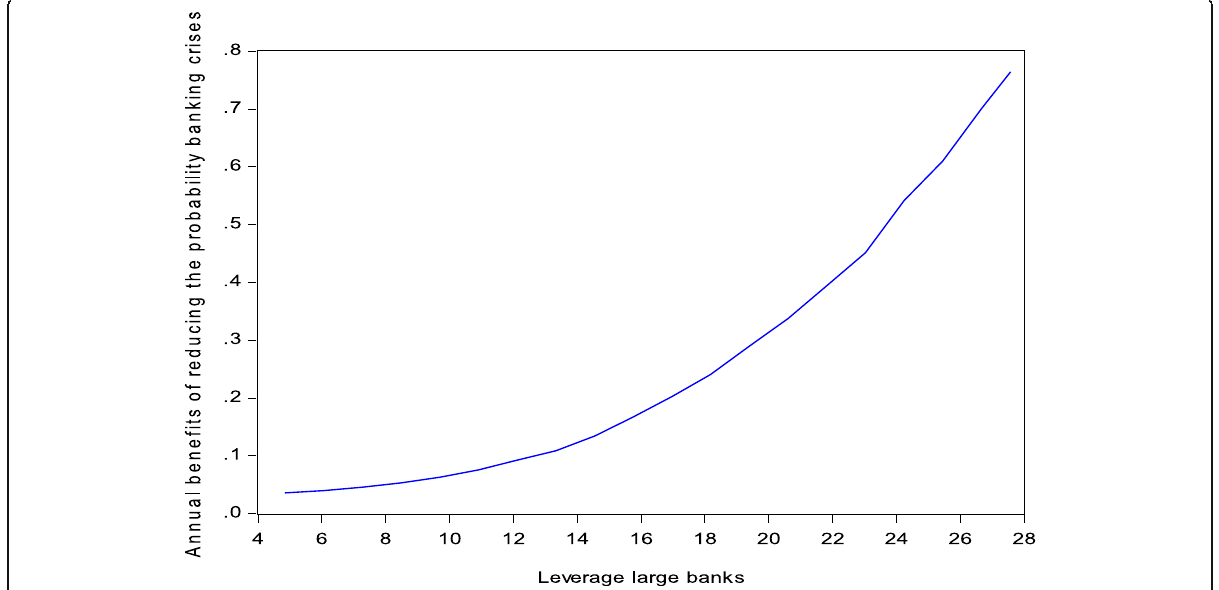
Fig. 1 Expected annual GDP benefits and trend leverage of large banks. Source: Junge and Kugler (2013), Figure